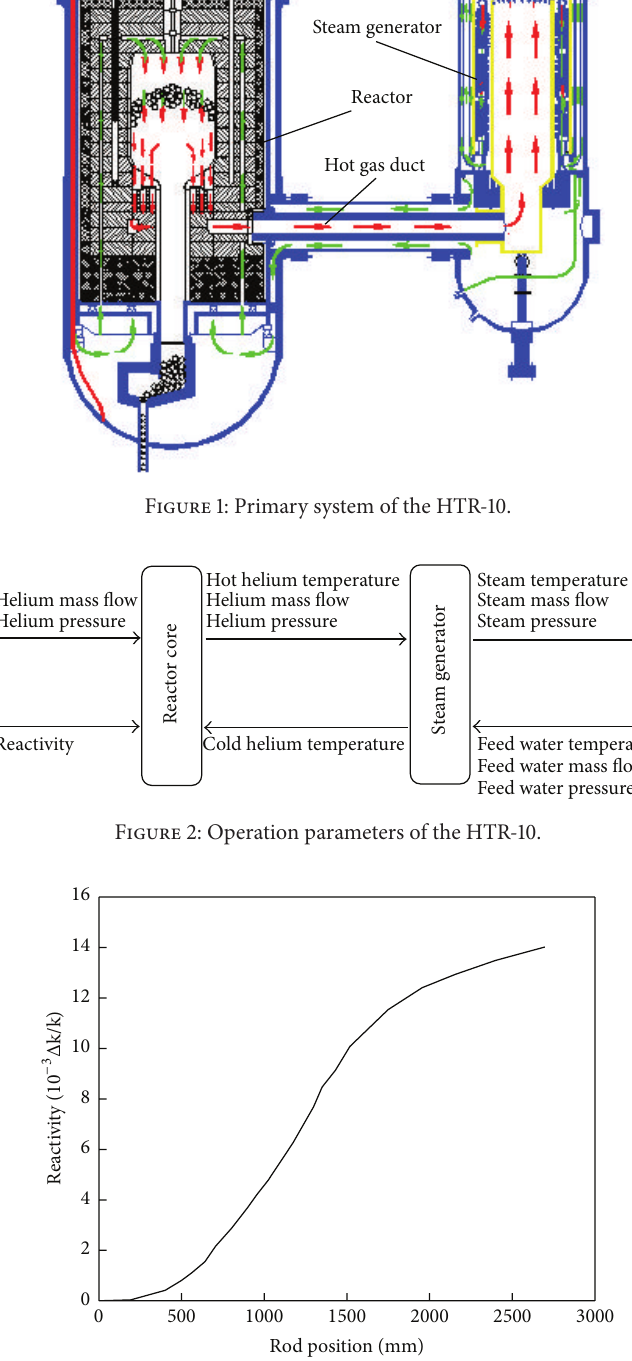
Figure 3: Measured reactivity worth of a single control